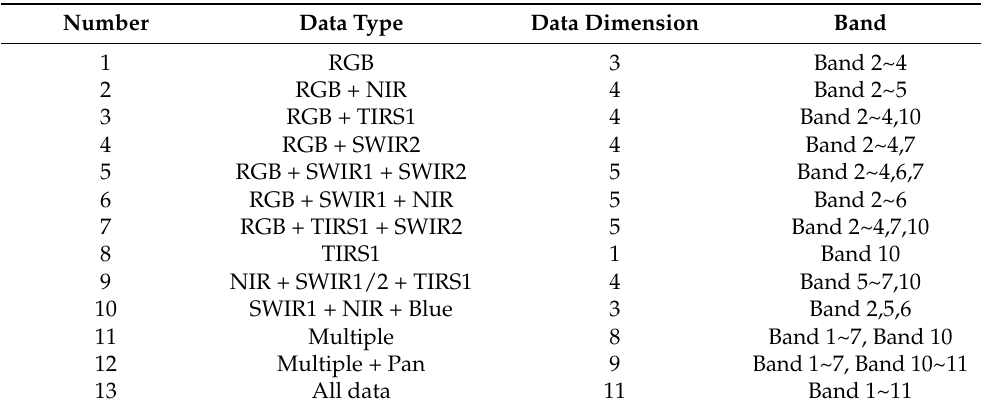
Table 5. Details of different bands